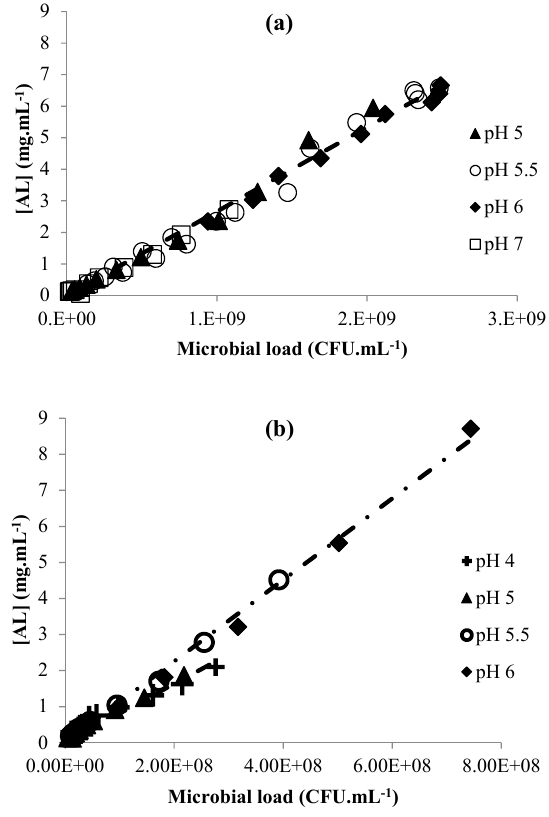
Figure 5. Regression between lactic acid concentration and microbial load for L. brevis ( a ) and L. plantarum ( b ) at pH 4 ( + ), 5 ( (cid:78) ), 5.5 ( ), 6 ( (cid:7) ).